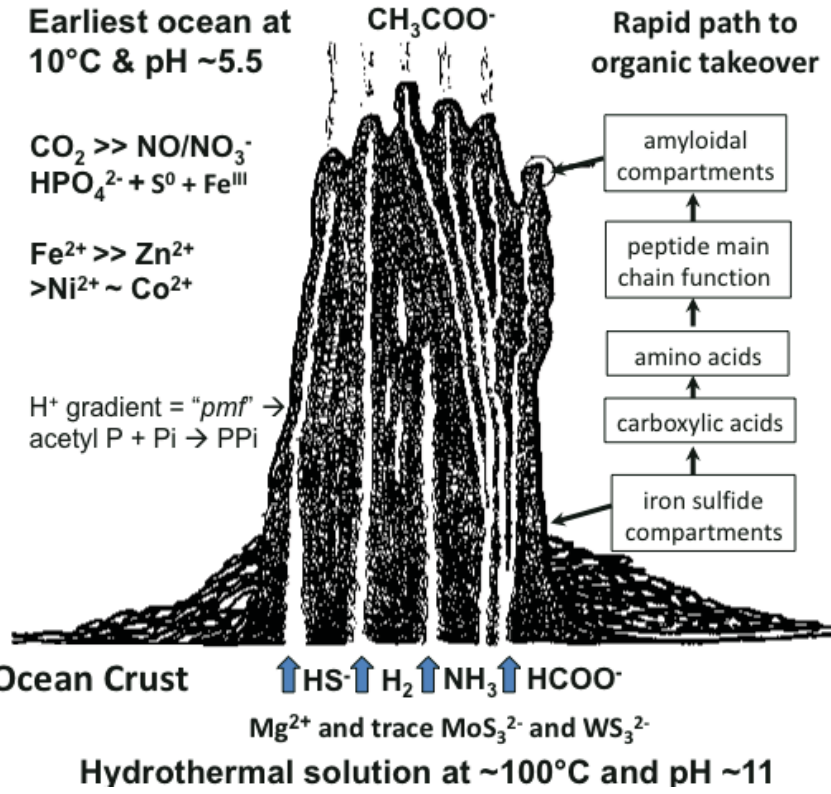
Figure 1. Cartoon of model low entropy environment for the emergence of metabolism via hydrothermal hydrogenation of oceanic CO , amination of carboxylic acids and the 2 condensation to disordered peptides. These reactions are hypothesized to take place in the outer porous iron sulfide-bearing walls to a submarine hydrothermal mound (see boxes on right of figure). Thermodynamic energy is boosted by the ambient proton-motive force. This force is assumed to have driven pyrophosphate generation, augmenting pyrophosphate of the substrate type formed by catalysis [7,8,20]. Amyloidal peptides eventually take over the role of compartment walls while retaining and nesting inorganic clusters of metals, metal sulfides and phosphate and allowing the transfer of potassium and water across these first membranes/cell walls [16,17]. In this way the properties both of the semipermeable and semiconducting membranous walls and of the catalytic propensities of the inorganic entities improve [21,22]. In this model the emergence of protometabolism from aqueous geochemistry predates transition to the RNA world